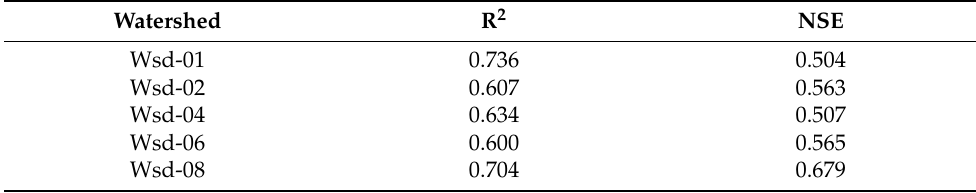
Table 5. R 2 and NSE of separated and estimated monthly baseflow in the first watershed